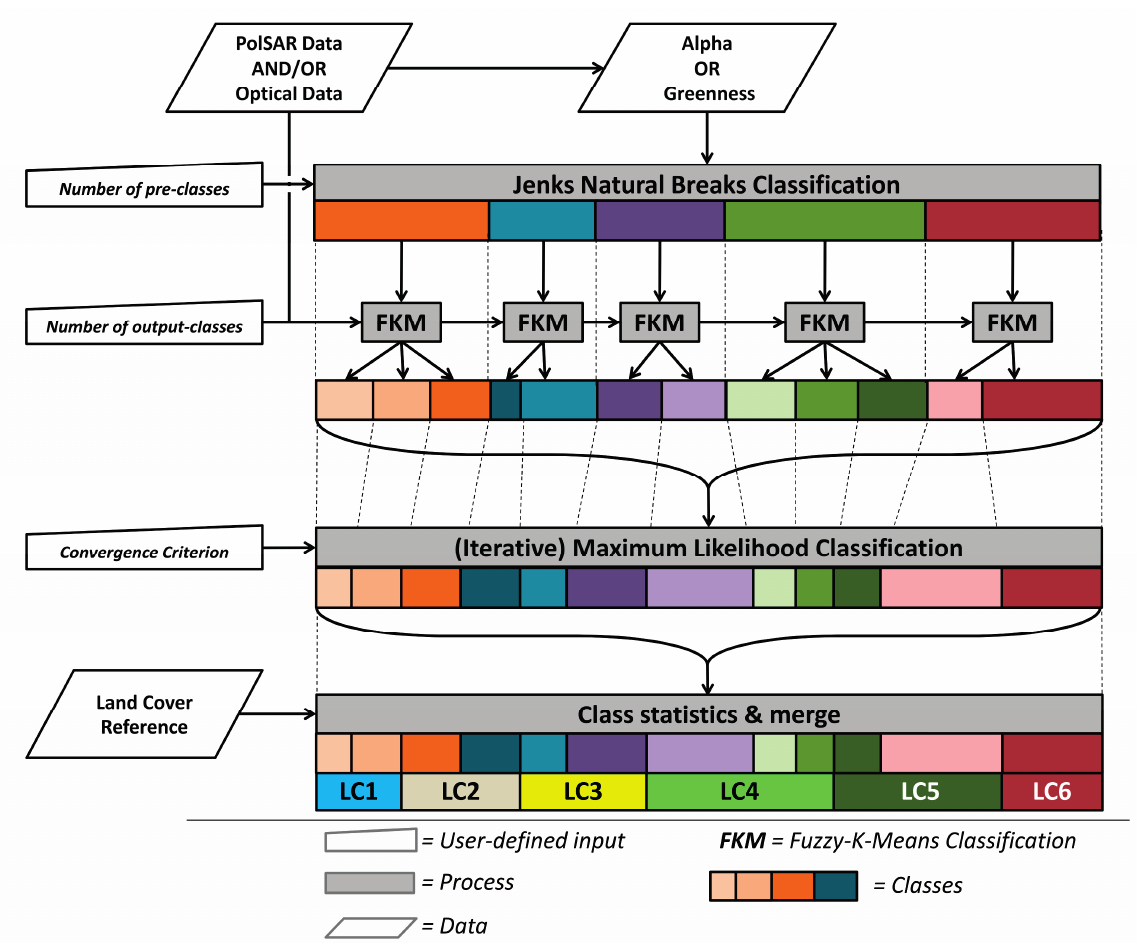
Figure 4. Simplified process chart of the unsupervised classification